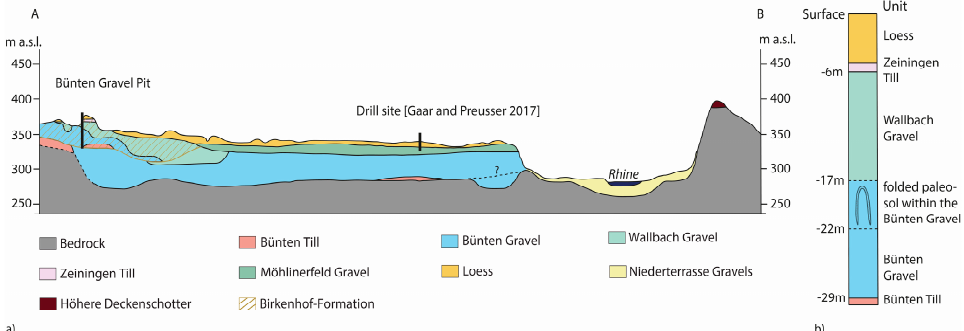
Figure 3. ( a ) Cross-section A–B showing the different units in the Möhlinerfeld (modified after [23]). ( b ) Stratigraphic column of the Bünten Gravel Pit (modified after [21]).